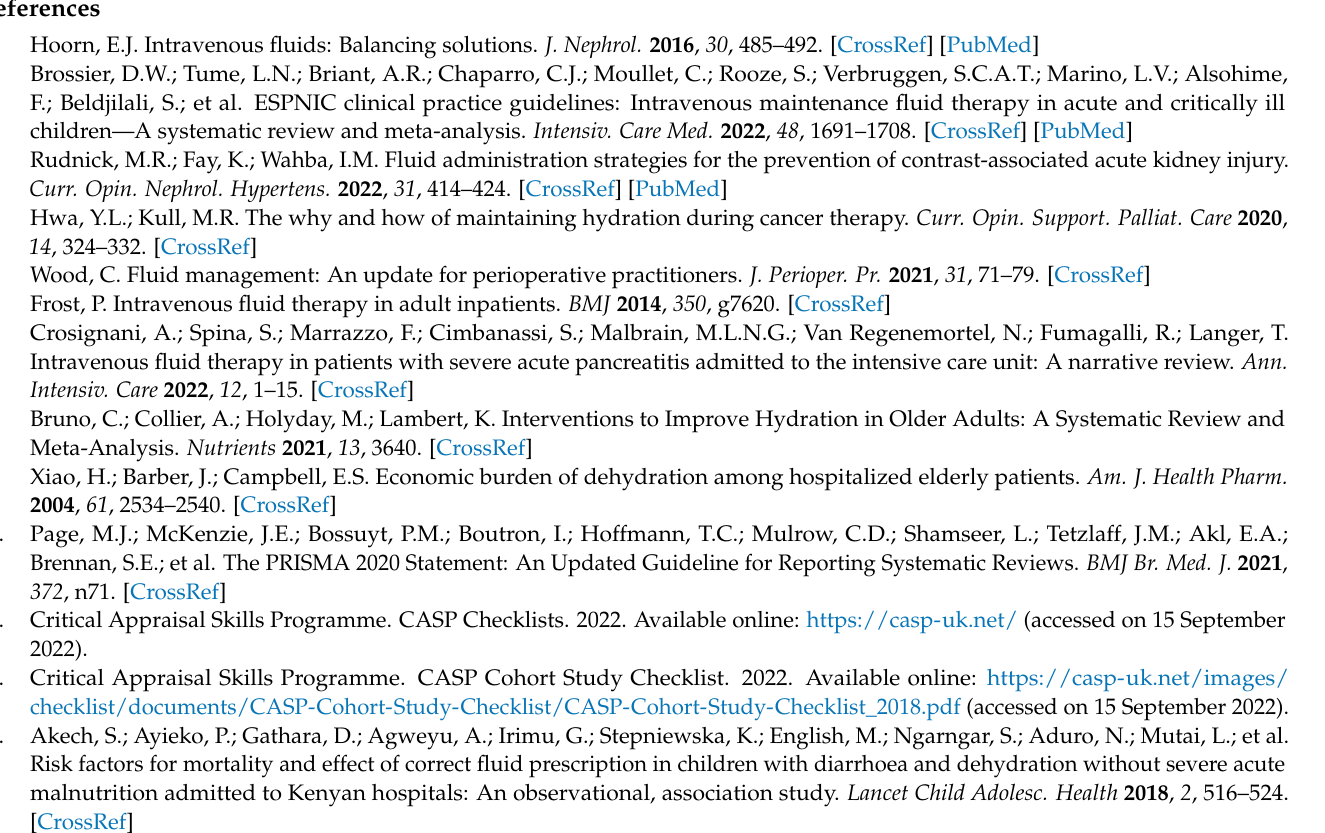
Table S2: Risk of bias in cohort studies; Table S3: Risk of bias in cross sectional